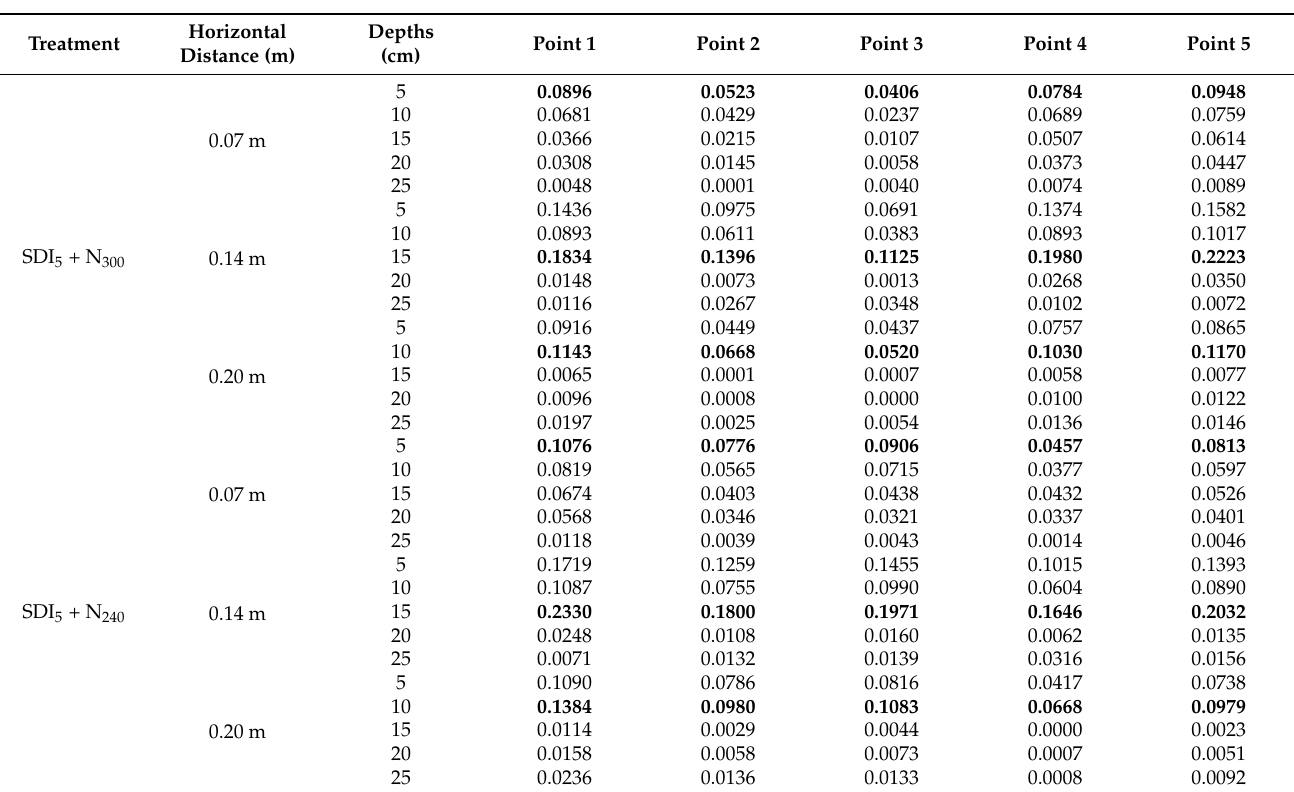
Table 1. Pearson correlation coefficients (R 2 ) between N 2 O emissions and soil moisture at different depths under the SDI 5 irrigation treatment.